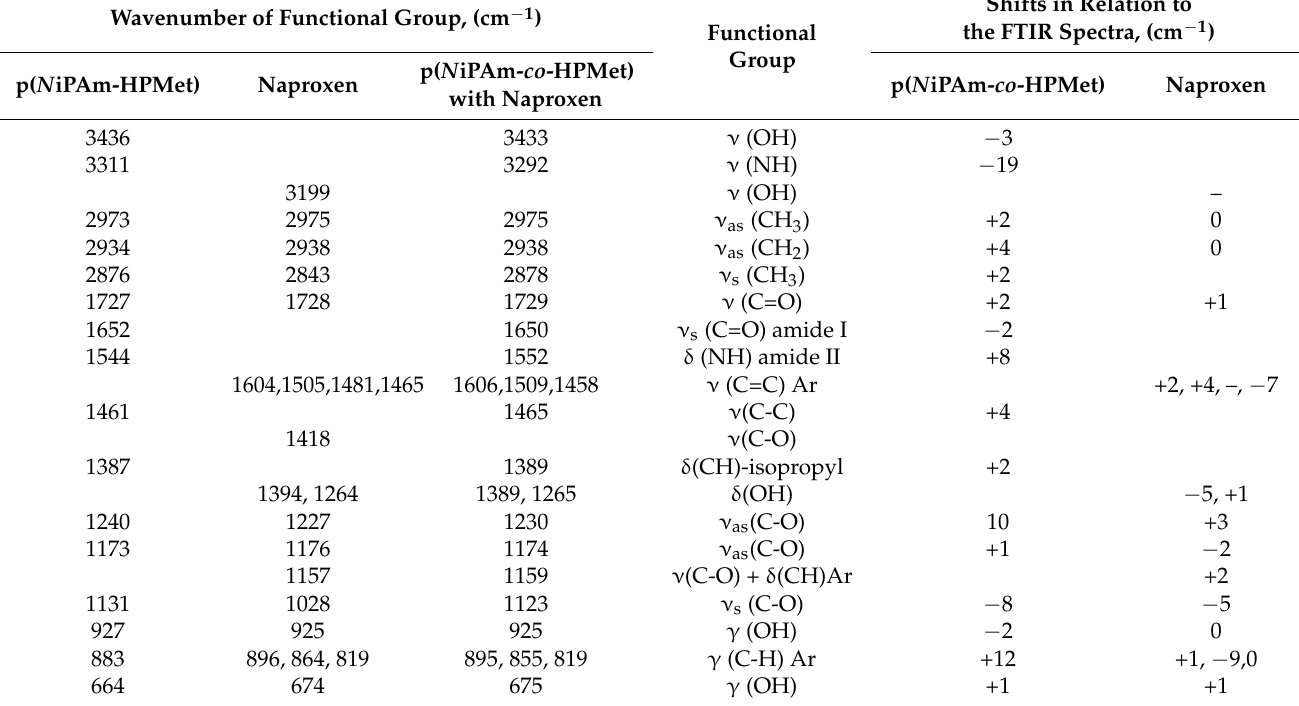
Table 3. The Maxima of Characteristic Absorption Bands from p( N iPAM- co- HPMet), Naproxen, p( N iPAM- co- HPMet) with Incorporated Naproxen and Value of Wavelengths Shifts after Drug Incorporation.